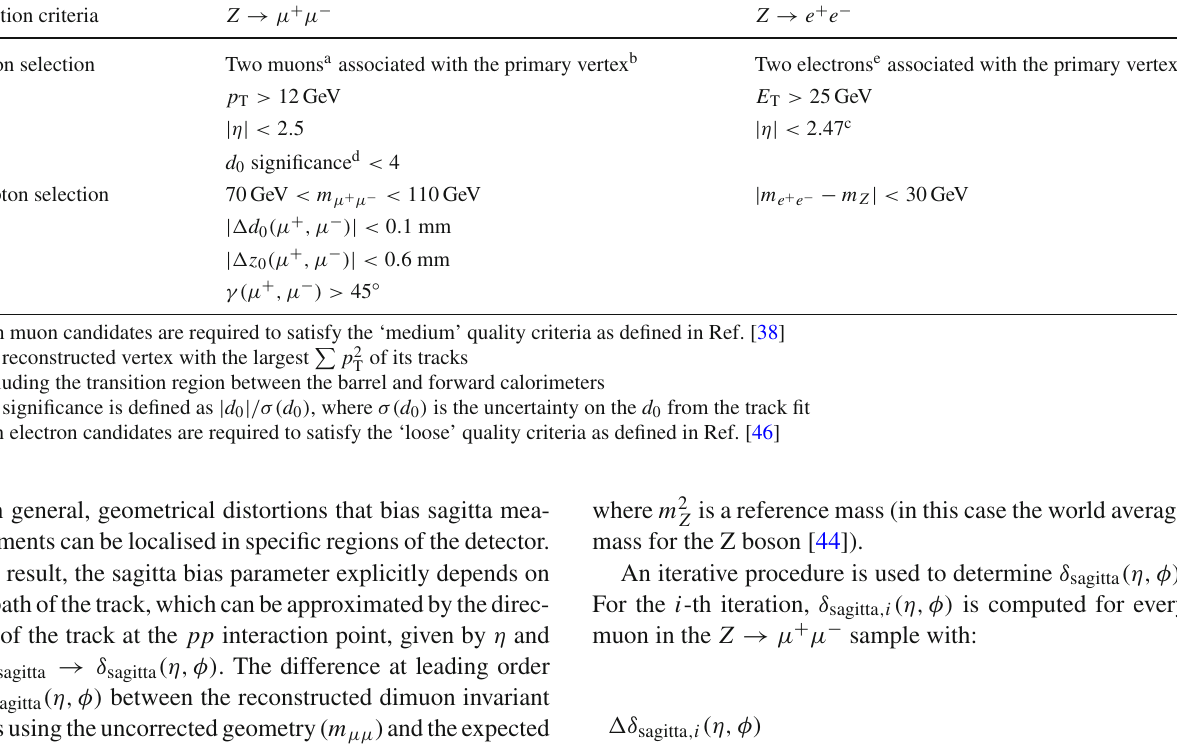
Fig. 17 A simplified representation of two common weak modes that biasthetrackmomentum.A sagitta bias(left)iscausedbyadeformation in the bending plane of the tracks, e.g. a rotation of the detector lay- ers depending linearly on the radius. A length scale bias (right) caused by a deformation along the track trajectory, e.g. a radial expansion of